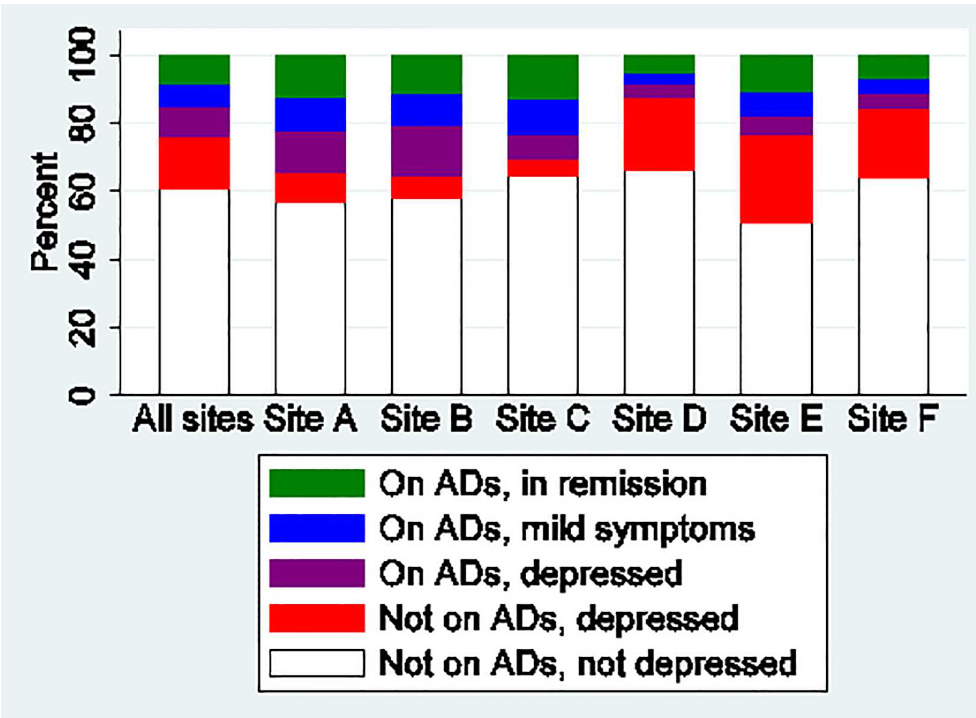
Fig 2. Distribution of depression and antidepressant treatment status across CNICS